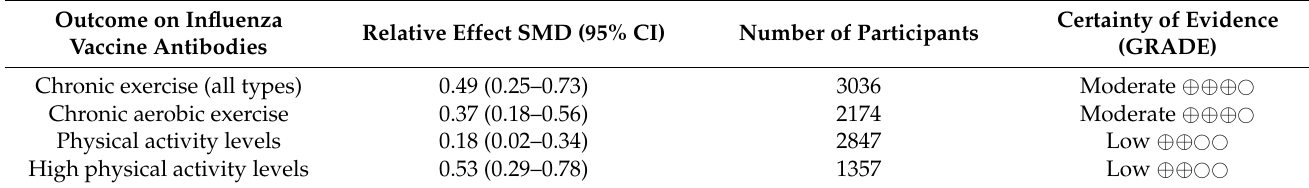
Table 2. GRADE analysis